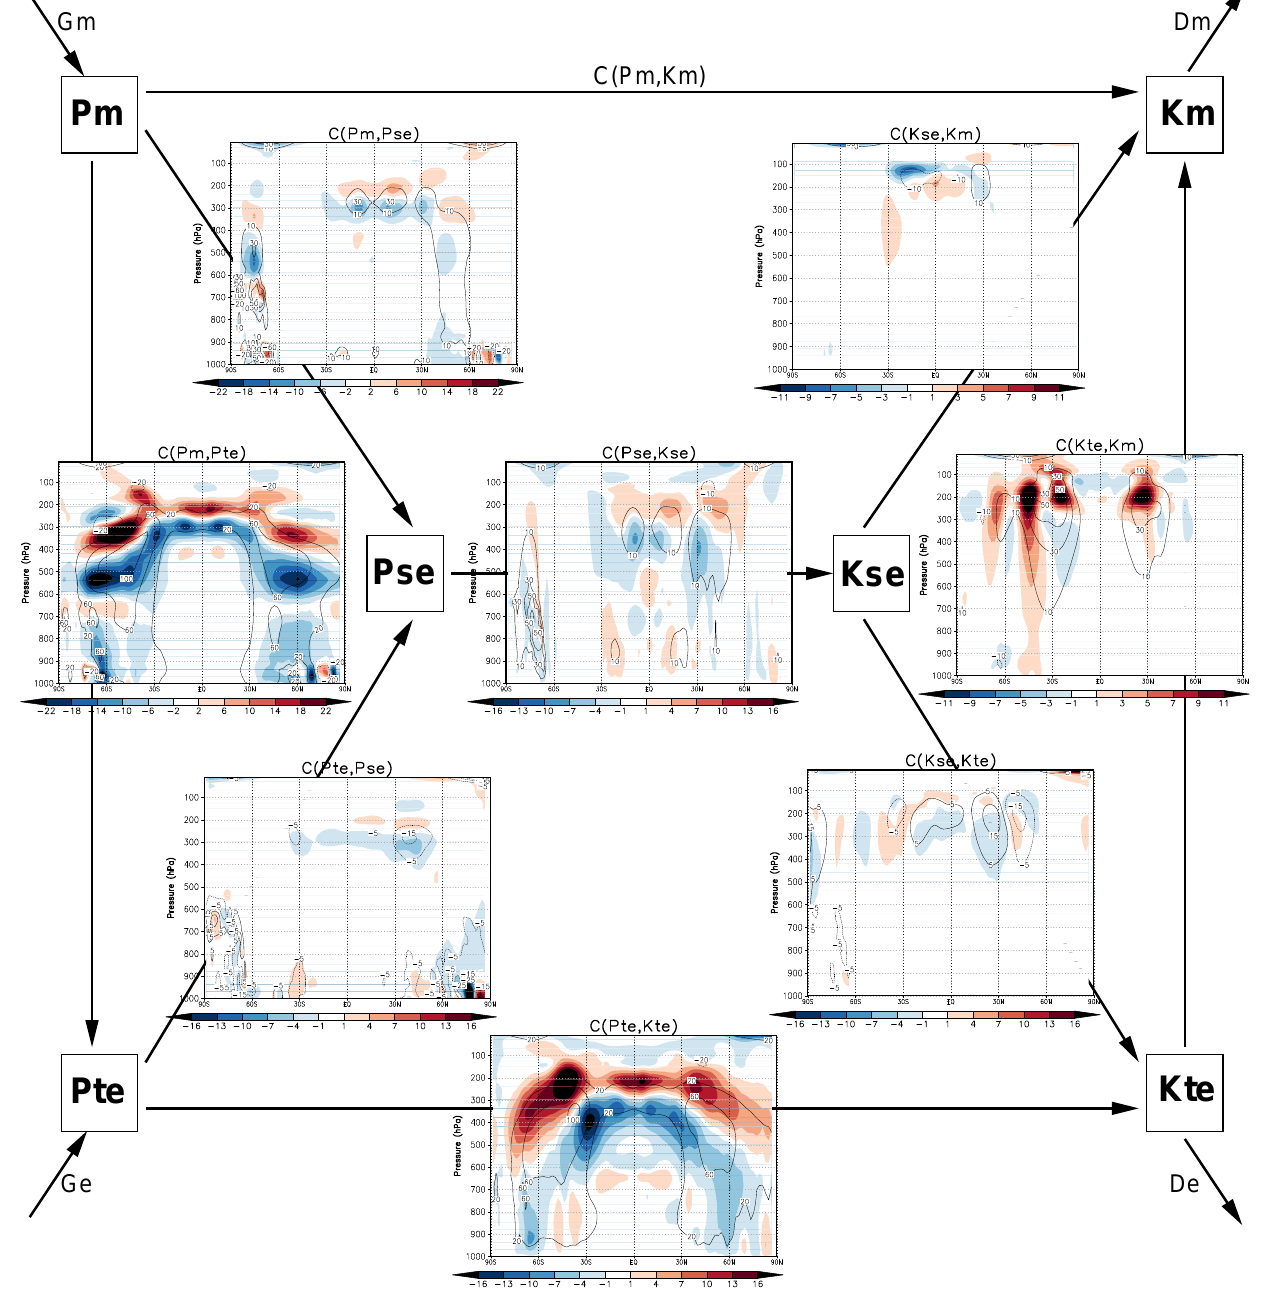
Fig. 7. Vertical cross sections of the stationary and transient eddy conversion terms ( C(P m , P te ) , C(P m , P se ) , C(P te , P se ) , C(P te , K te ) , C(P se , K se ) C(K te , K m ) , and C(K te , K m ) ) for the 1 × CO 2 control experiment (contours), and their 2 × CO 2 change (color shaded). Units are 10 − 5 Wkg − 1